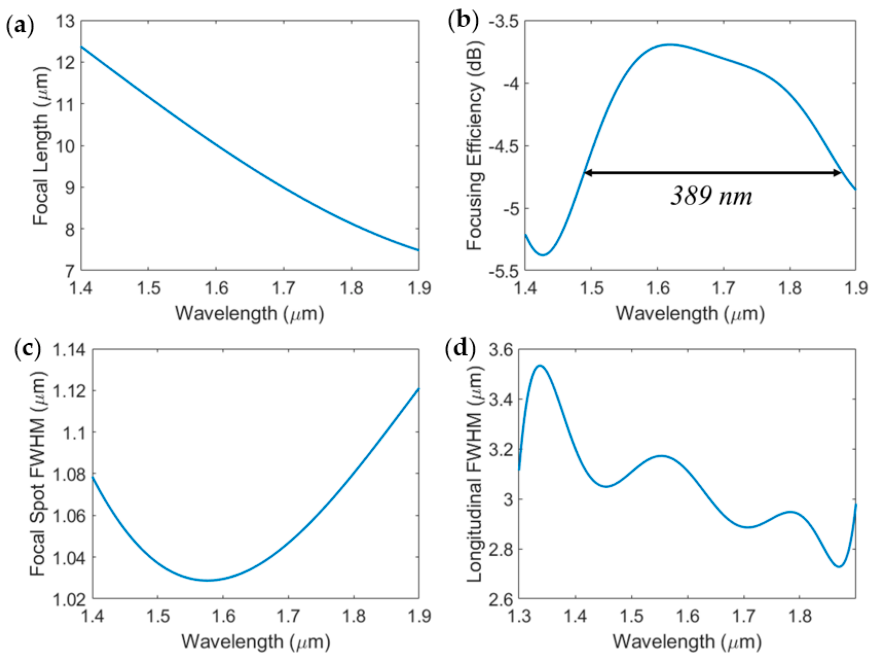
Figure 9. Wavelength dependence of ( a ) focal length, ( b ) focal spot transversal FWHM, ( c ) focal spot longitudinal FWHM, and ( d ) the focusing efficiency of our proposed BPFZP with uniform SWG duty cycle. Table 1. Comparison of results with previously reported metalenses.